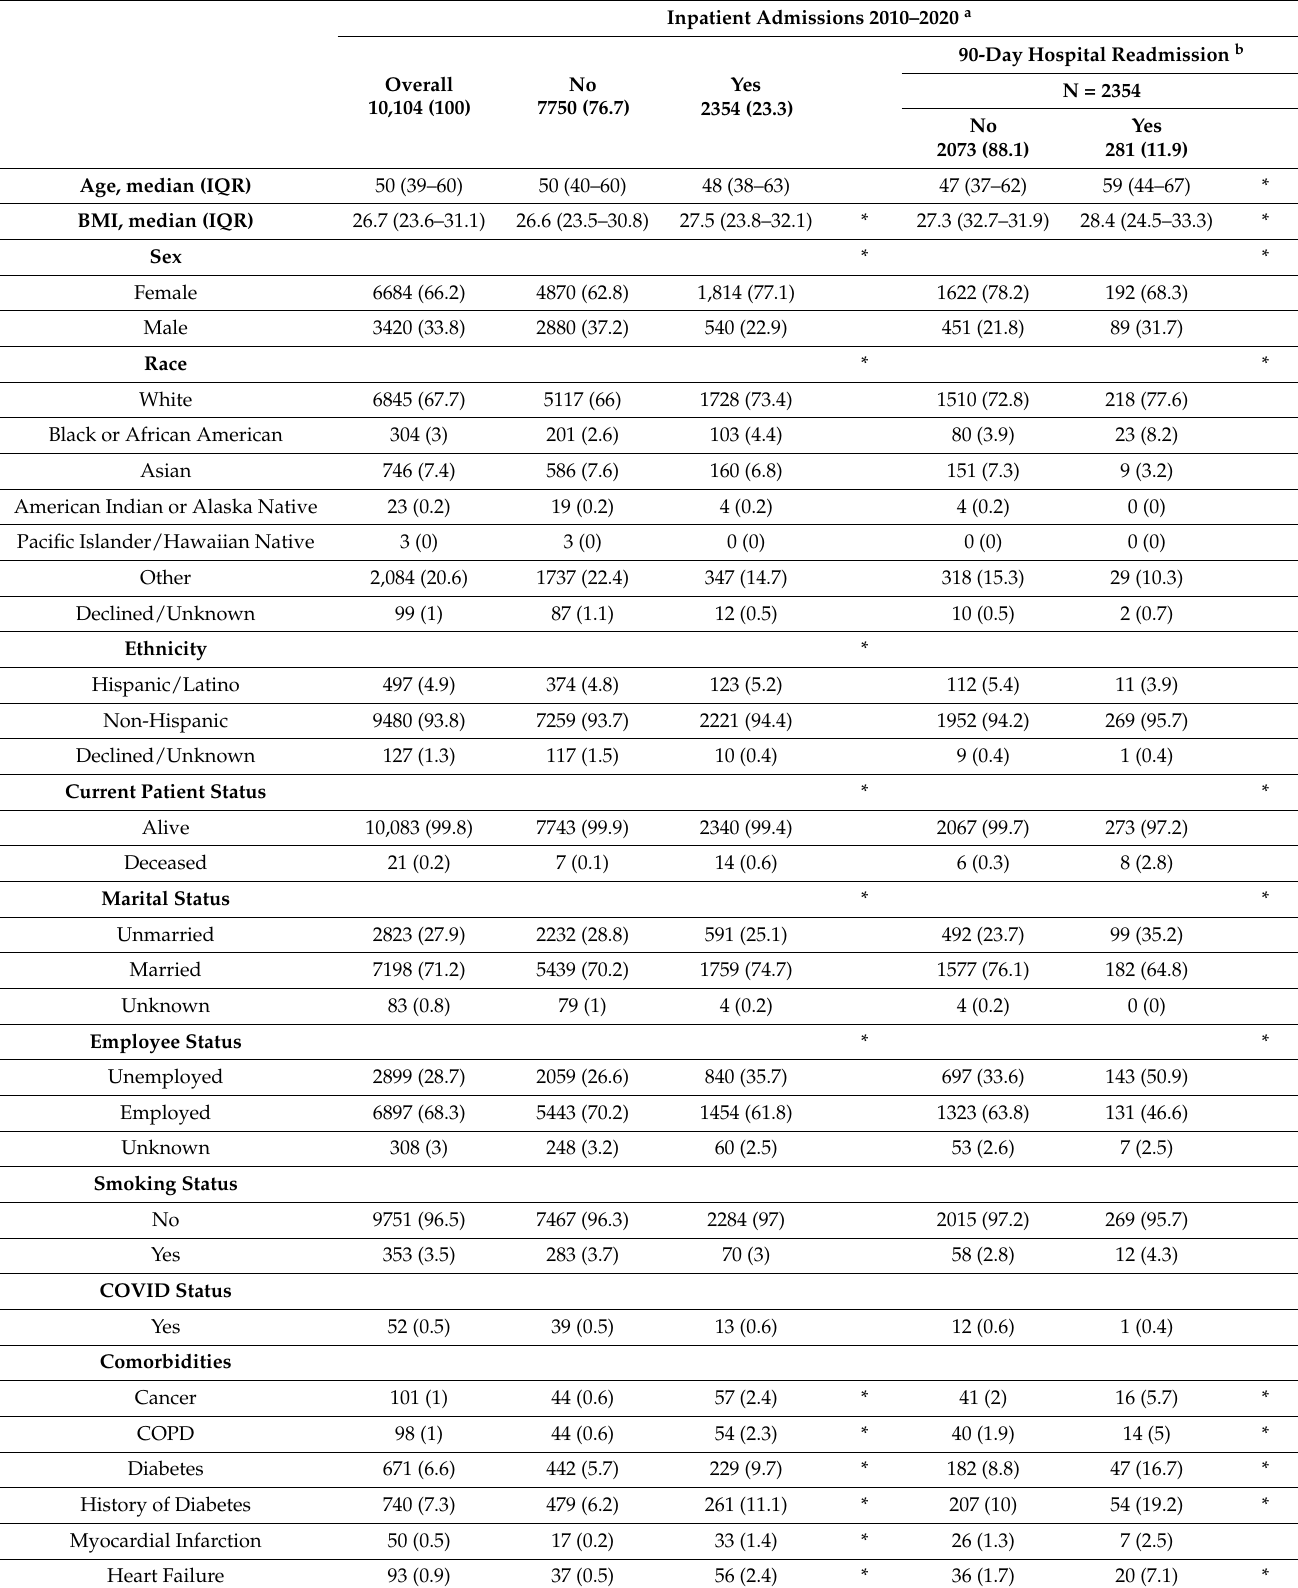
Table 1. Demographic and clinical characteristics of DNA10K patient